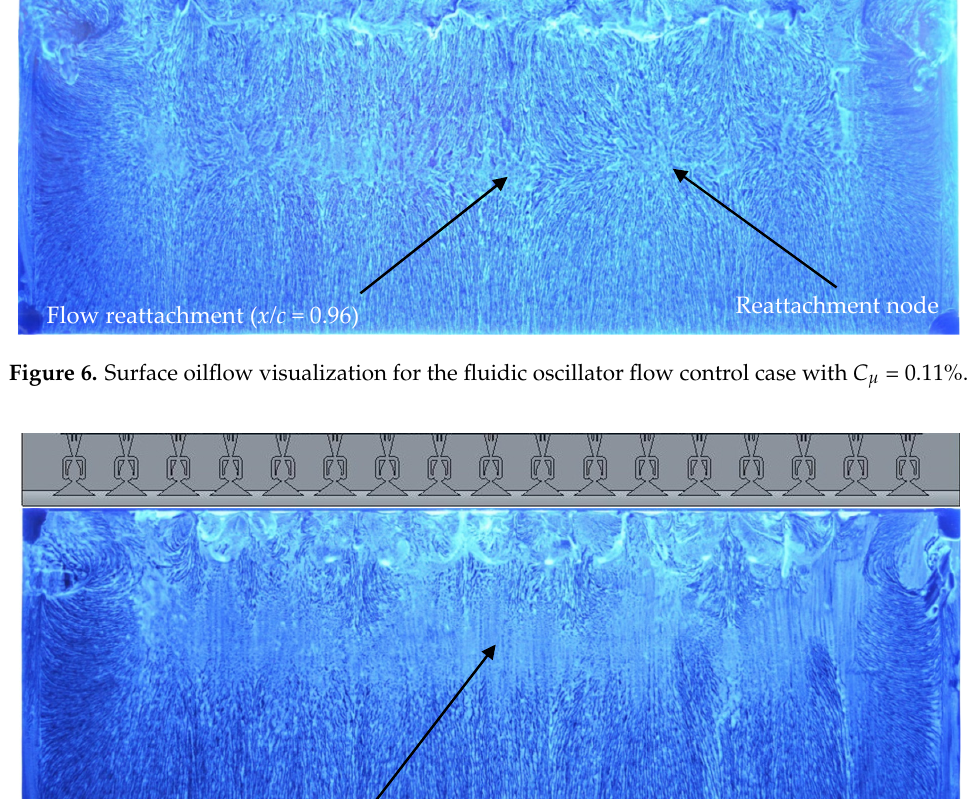
Flow reattachment ( x/c = 0.85)